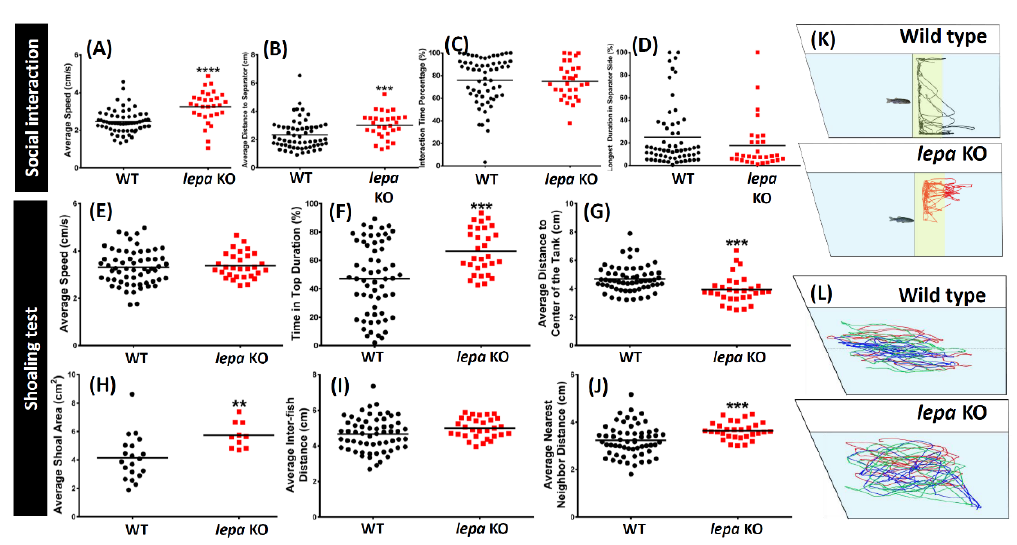
Figure 4. Comparison of several behavior endpoints of untreated wild type and lepa KO zebrafish in social interaction test ( A – D ) and shoaling test (group of three fish) ( E – J ). ( A ) average speed; ( B ) average distance to separator; ( C ) interaction time percentage; ( D ) longest duration in separator side; ( E ) average speed; ( F ) time in top duration; ( G ) average distance to center of the tank; ( H ) average shoal area; ( I ) average inter-fish distance; and ( J ) average nearest neighbor distance. ( K ) Locomotion trajectory of wild type (top) and lepa KO (bottom) zebrafish in social interaction test. The normal zebrafish is placed in the left side and tested KO fish is placed in the right site and one transparent glass plate is inserted to separate both animals. The social interaction approaching zones are highlighted in yellow color. ( L ) Locomotion trajectory of three wild type (top) and lepa KO (bottom) zebrafish in shoaling test. The shoaling trajectories for each single fish are labeled in different color. The data were expressed as the mean ± SEM and were analyzed by Mann–Whitney test ( n = 30; ** p < 0.01, *** p < 0.001, **** p < 0.0001).